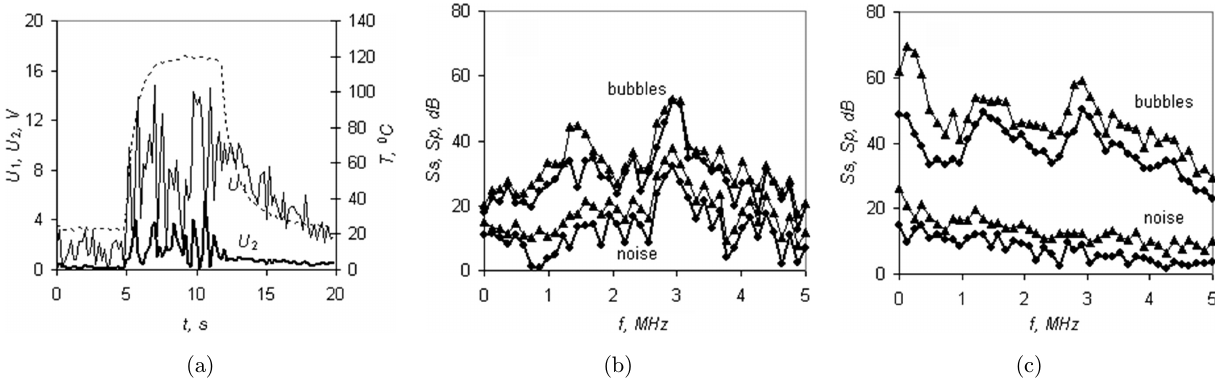
Fig. 4. Amplitude of the f 1 and f 2 frequencies and sensor temperature ( — ), and changes of the average ( (cid:5) ) and peak ( ~ ) values of the signal and noise spectra for un-coated optical ¯bers (a, b) and with a strongly absorption coating (c).